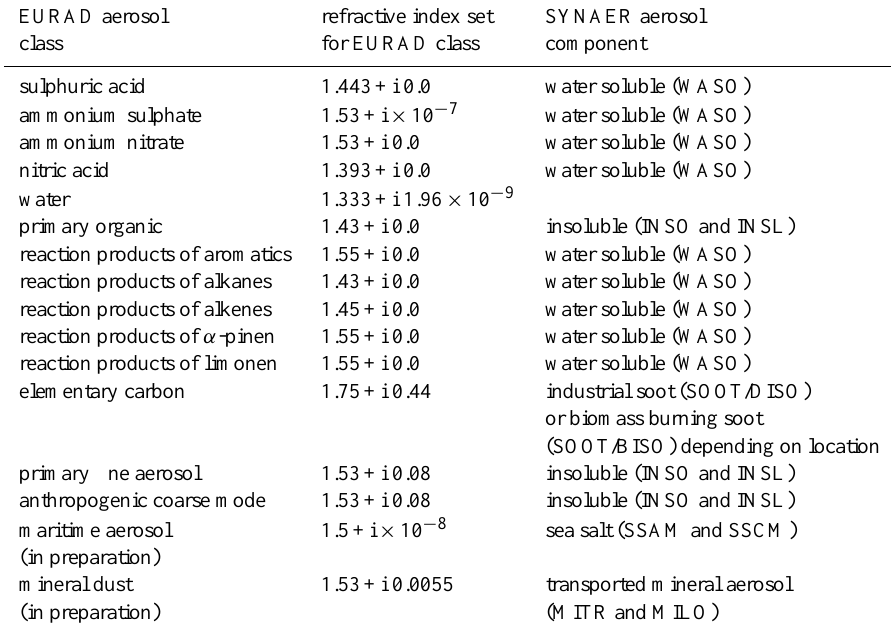
Table 2. Mapping of EURAD aerosol classes to SYNAER aerosol components together with the refractive index chosen for EURAD aerosol